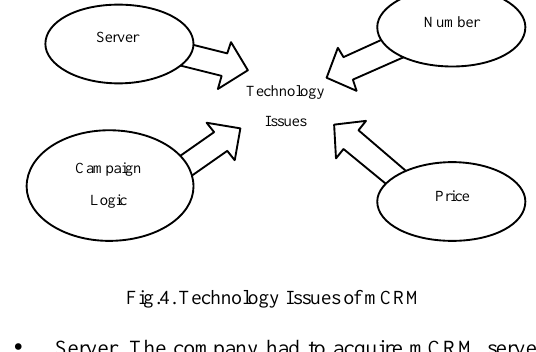
Table 1. The relationship between importance, satisfaction and priority.